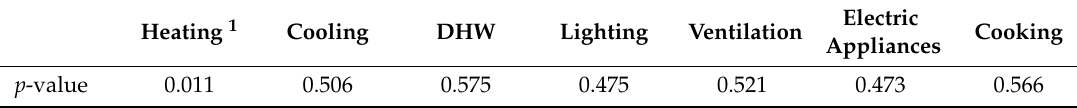
Table 6. Paired T-test results for 10 households’ measurement data of test and training sets.